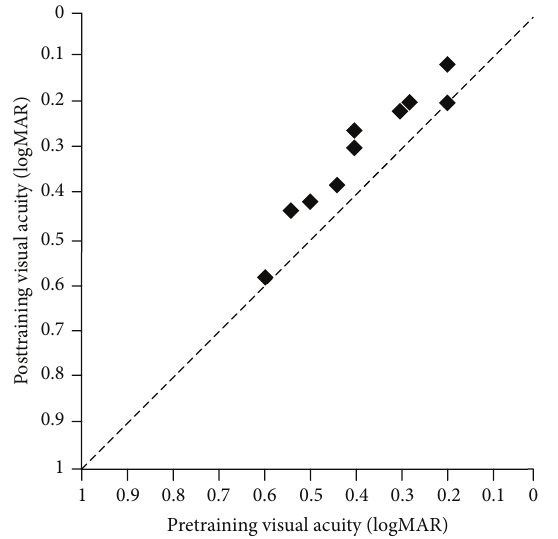
Figure 5: Visual acuity in amblyopic eye before and after the training. The x -axis represents the visual acuity (logMAR) of the subjects before the treatment and the y -axis represents the visual acuity (logMAR) of the subjects after the treatment. Results indicate improvement in visual acuities of the amblyopic eye after the ISVA training ( 𝑃 = 0.000